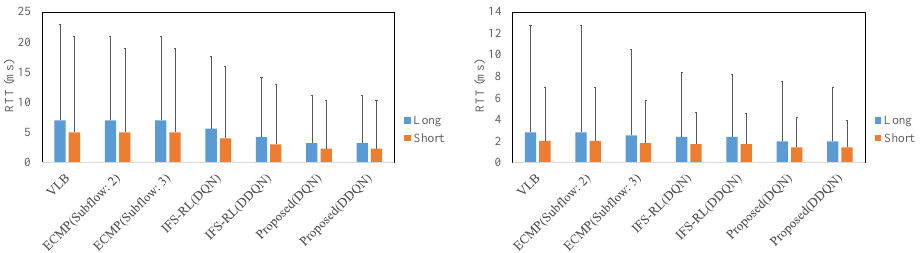
Figure 9. RTT against the length of TCP flows (( Left ): the case for complex architecture, ( Right ): the case for non-complex architecture).